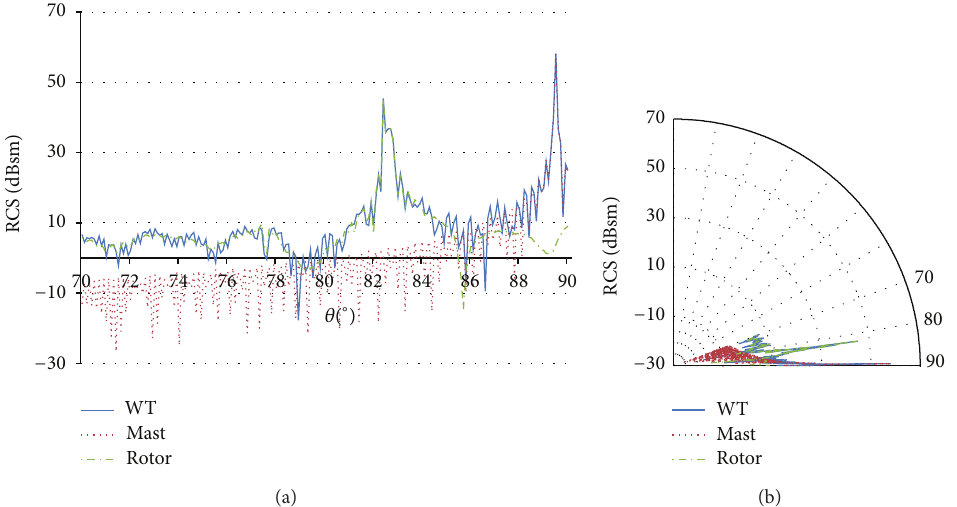
Figure 4: Wind turbine (blue line), mast (red dotted line), and rotor (green dotted line) RCS vertical pattern for the turbine model 1 at 3.08 GHz ( 𝜙 = 30 ∘ and 70 ∘ < 𝜃 < 90 ∘ ). Polar (a) and Cartesian (b) coordinate representations.